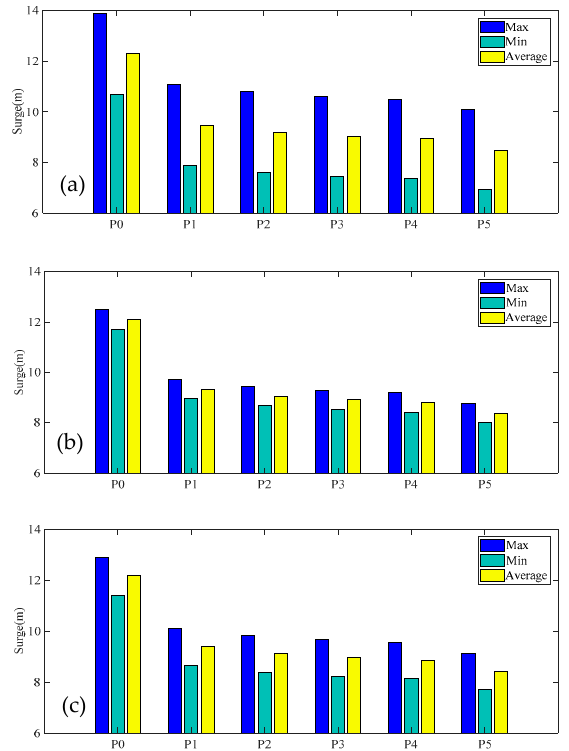
Figure 8. The maximum and minimum values and average values of surge motion from 600 s to 900 s for ( a ) case 1, ( b ) case 2, and ( c ) case 3.